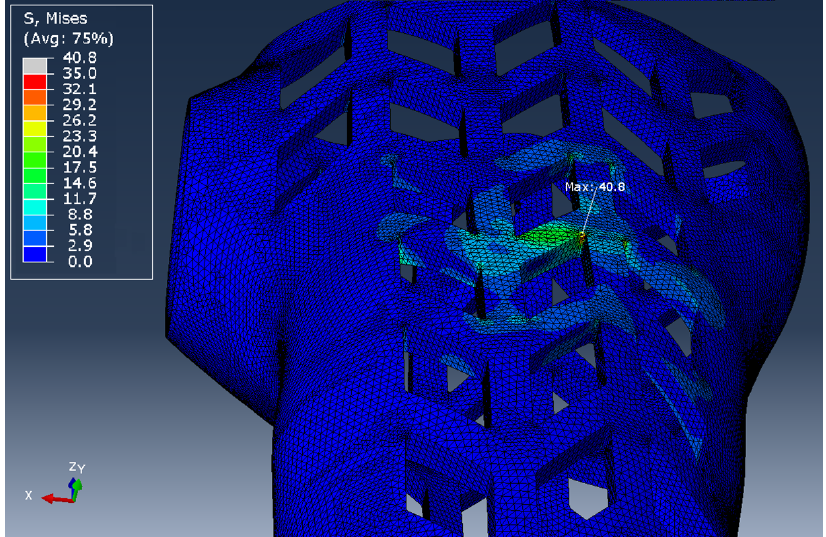
Figure 11. The obtained von Mises stress map on the WHO.1 orthosis model, visible local stress concentration of 40.8 MPa.